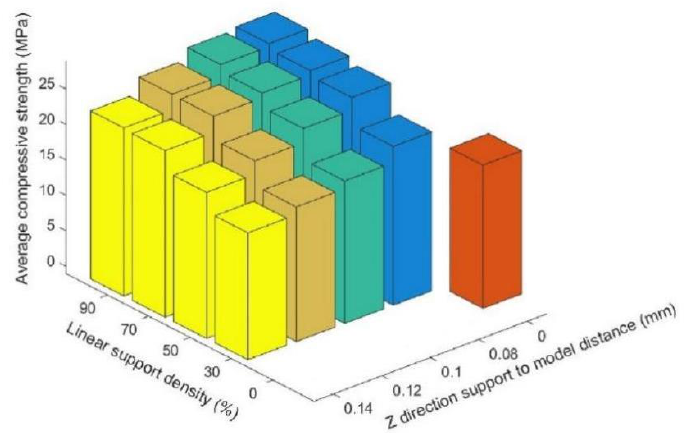
Figure 6. Relationship between density, Z direction support-to-model distance, and average com- pressive strength under linear support.